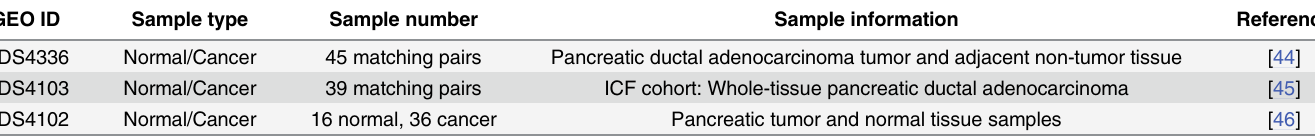
Table 1. Summary of the three pancreatic cancer gene expression